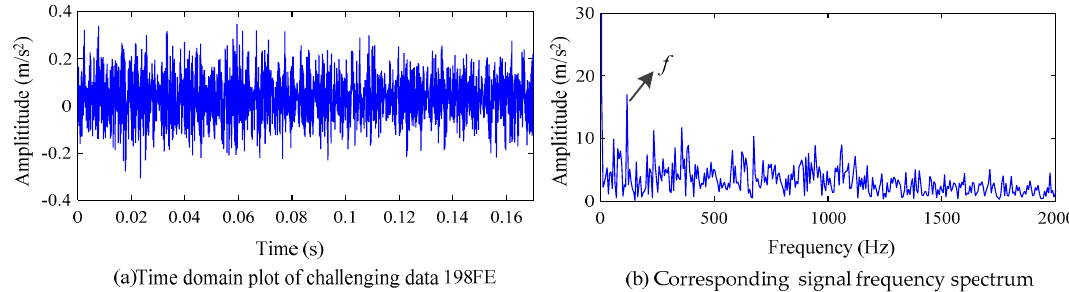
Figure 28. Time domain plot of challenging data 198FE and envelope spectrum.